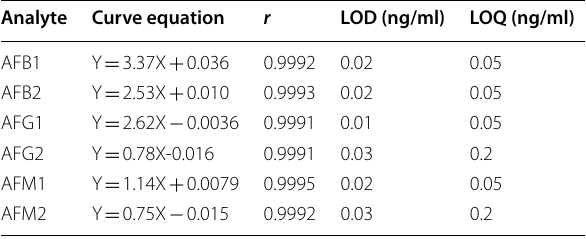
Table 2 Calibration, LOD, and LOQ of aflatoxin in blood Analyte Curve